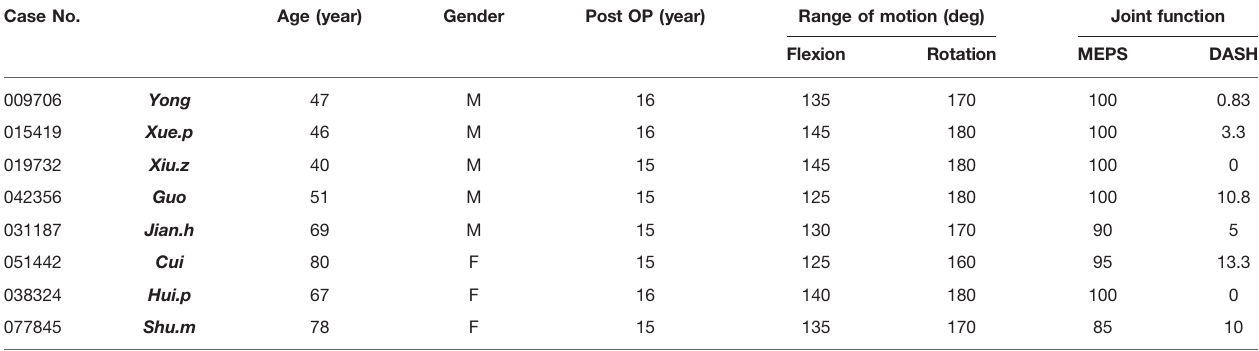
TABLE 3 | Long-term review of patients more than 15 years postoperation. Case